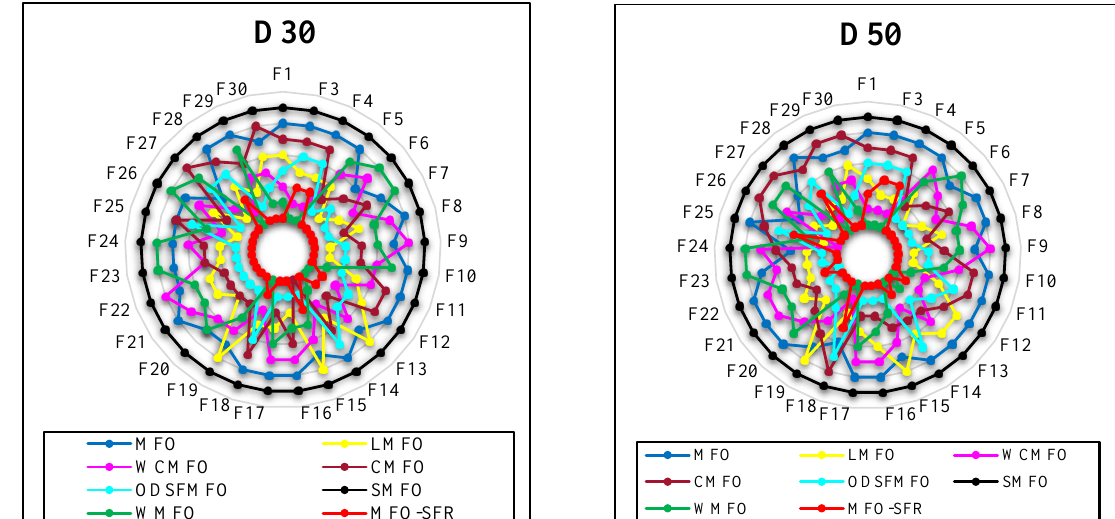
Figure 1. Exploratory data analysis of MFO-SFR, MFO, and its variants on CEC 2018 with 30 and 50 dimensions.